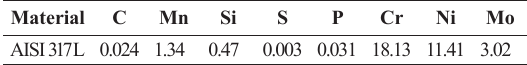
Table 1. Chemical composition of the base metal (wt%). (Fe) balance.